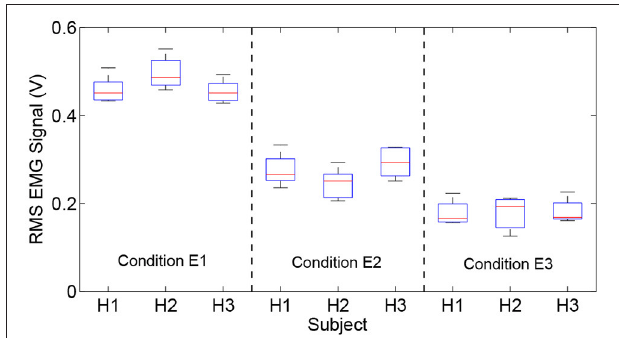
FIGURE 9 | Experimental scenarios of a healthy volunteer conducting virtual airplane-game operation experiment.